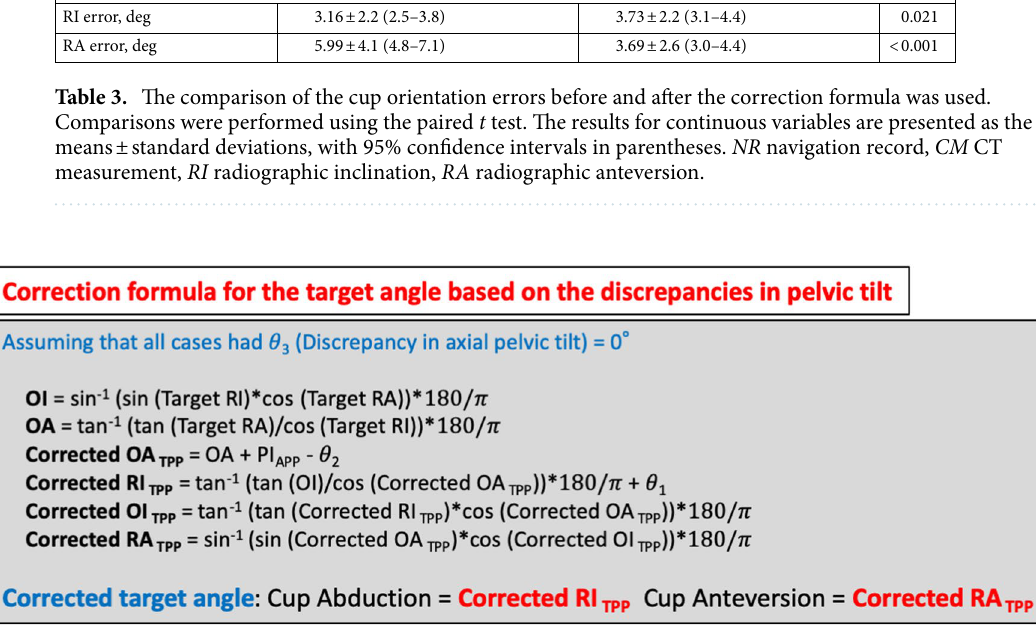
Figure 5. Correction formula for the target angle based on the discrepancies in pelvic tilt, as measured by TPP images. In the future, we plan to use this correction formula to determine the target cup orientation angle. It will be necessary to minimize the angle of θ 3 in order to achieve more accurate installation. RI, radiographic inclination; RA, radiographic anteversion; OI, operative inclination; OA, operative anteversion; TPP, table parallel plane; RI TPP , RI based on the TPP; RA TPP , RA based on the TPP; OI TPP , OI based on the TPP; OA TPP , OA based one TPP; θ 1 , discrepancy in coronal pelvic tilt; θ 2 , discrepancy in sagittal pelvic tilt; θ 3 , discrepancy in axial pelvic tilt; PI APP , pelvic inclination of anatomic pelvic plane in the supine